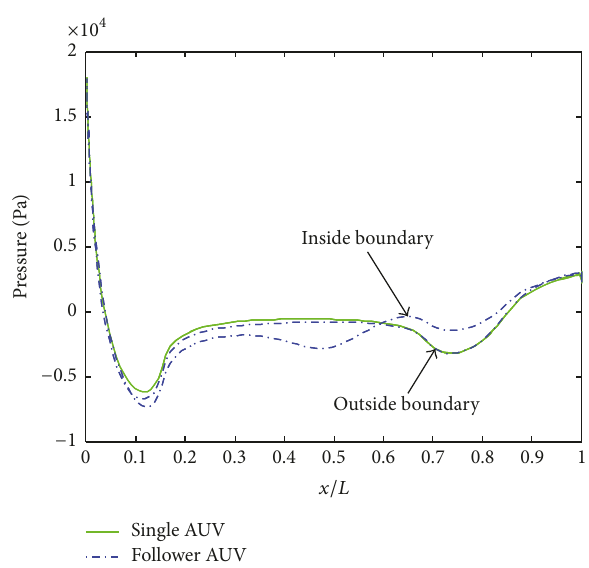
Figure 20: Pressure distributions along the longitudinal direction of the AUV: (a) single AUV and (b) optimal AUV